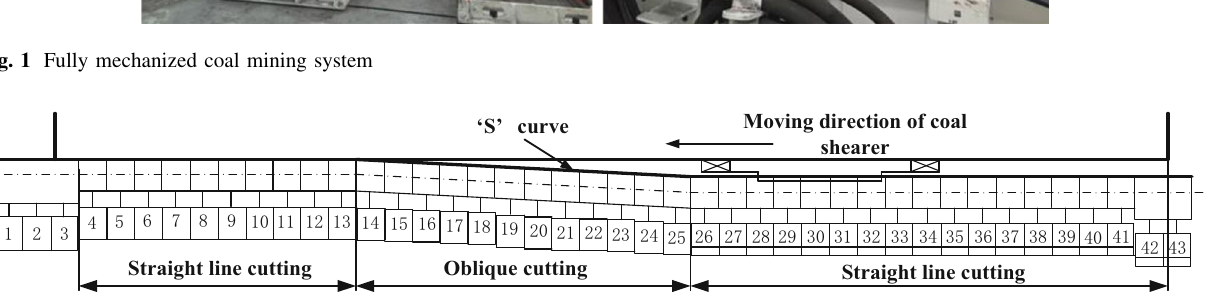
Fig. 2 Fully mechanized mining